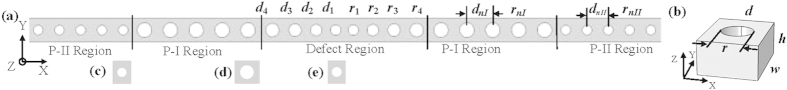
(a) The plan-view schematic of the proposed optomechanical crystal nanobeam cavities. (b) The unit cell constituting the structure. (c–e) The unit cells constituting P-II, P-I regions and one of the two central holes.